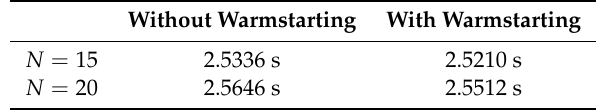
Table 2. Comparison of the average computation time with and without warmstarting. Without Warmstarting With